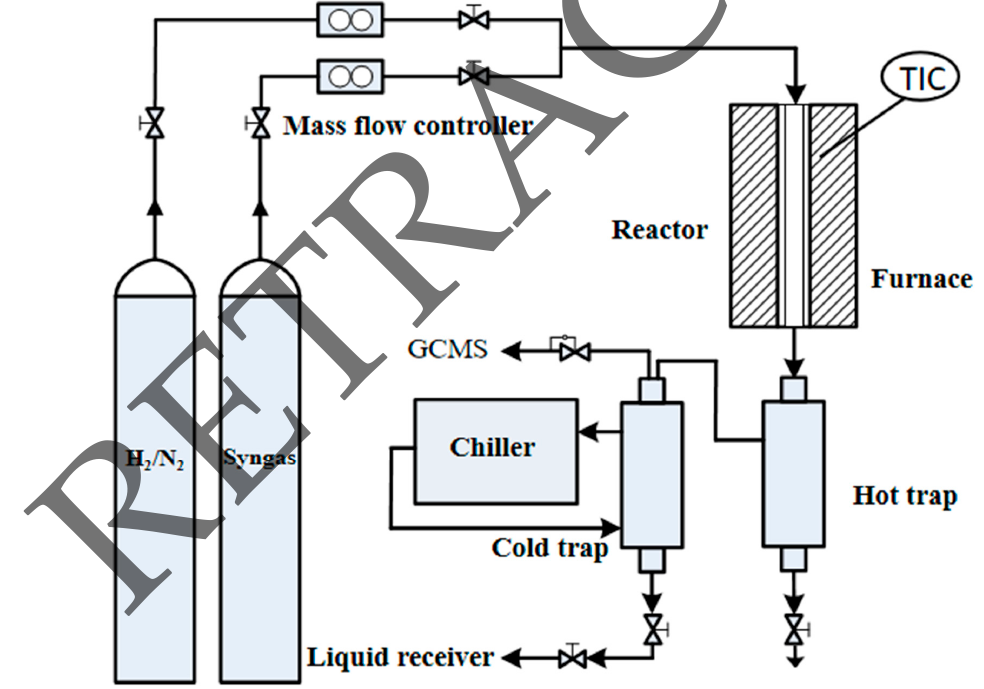
Figure 11. Schematic of experimental setup for FTs.